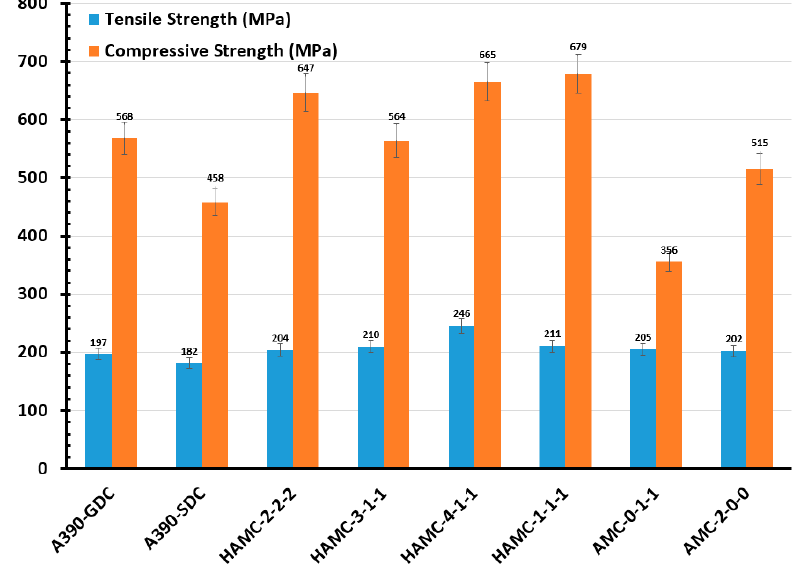
Figure 7. Average values of tensile and compressive strength of material samples.